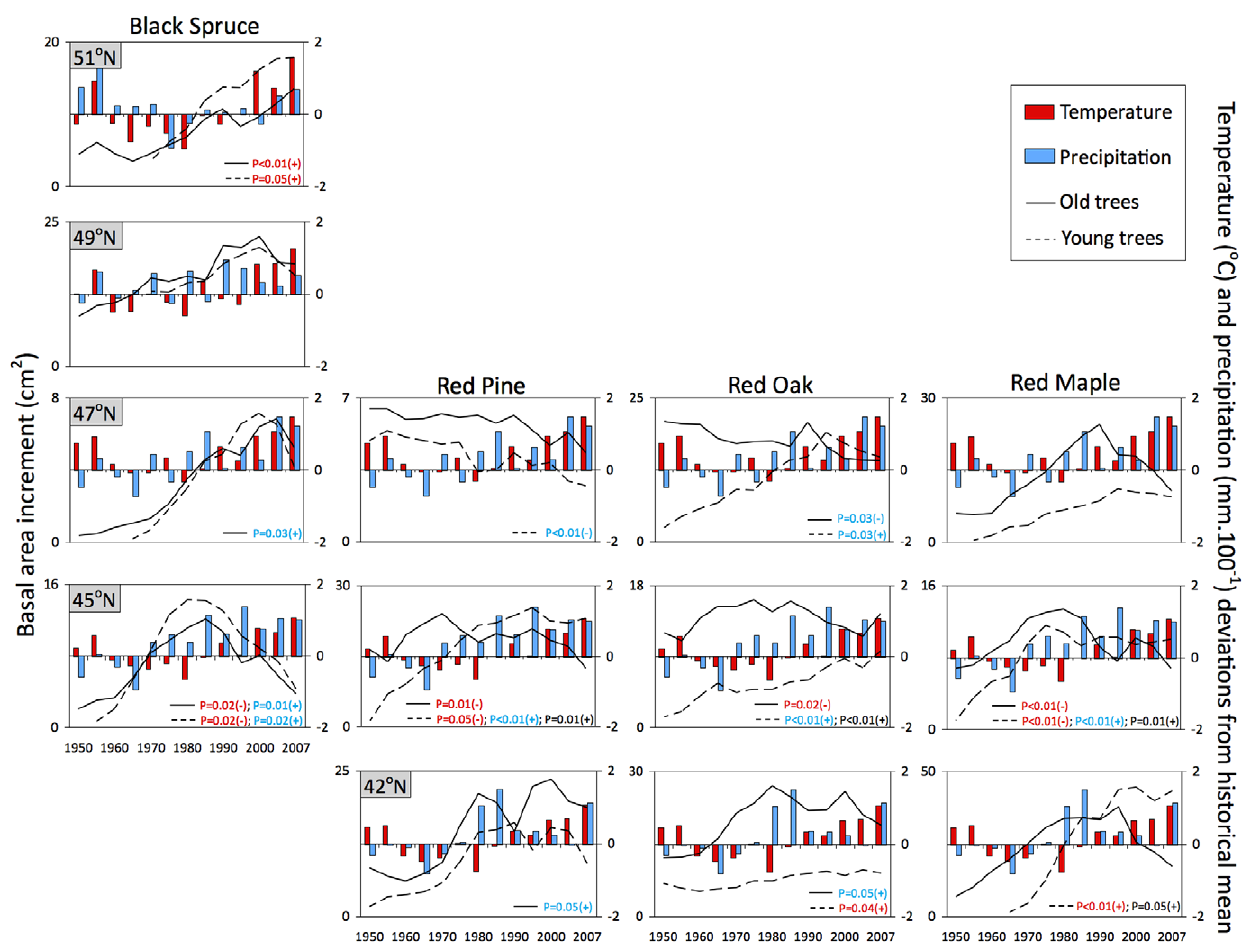
Figure 2. Five years averaged annual mean precipitation and temperature since 1950, deviations from the historical mean (1900– 2007) and basal area increment (BAI) for the five youngest (dashed lines) and five oldest (solid lines) trees for black spruce - Picea mariana (Mill.) B. S. P.; red pine - Pinusresinosa Ait.; red oak - Quercusrubra L. and red maple - Acerrubrum L., along a latitudinal gradient in Ontario, Canada. P values represent significant correlations between BAI and temperature (red), precipitation (blue) or their interaction (black).